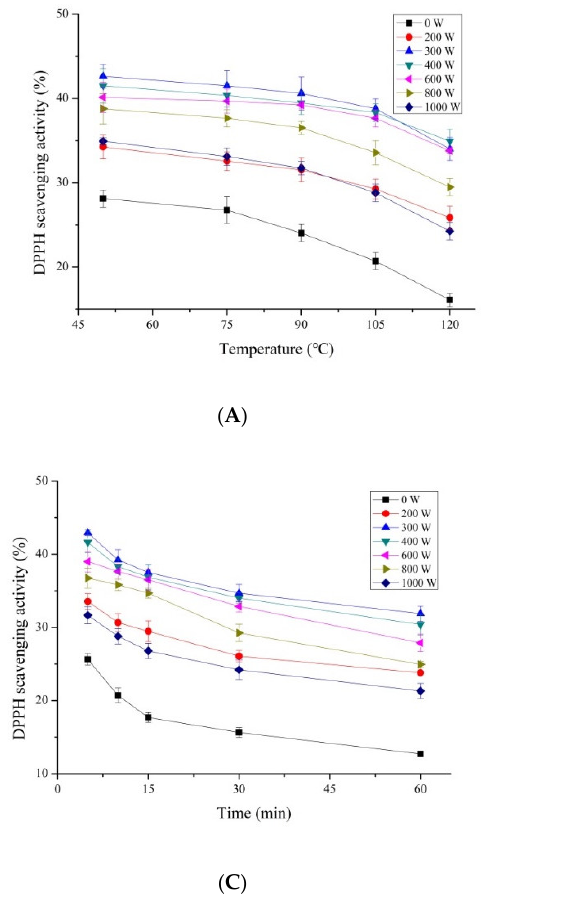
Figure 3. Thermal treatment on the DPPH scavenging activity ( A ), total antioxidant capacity ( B ), treatment time on the DPPH scavenging activity ( C ), and total antioxidant capacity ( D ) of MP hydrolysate after pretreated by microwave. Results represent the means of three determinations ± standard deviation.